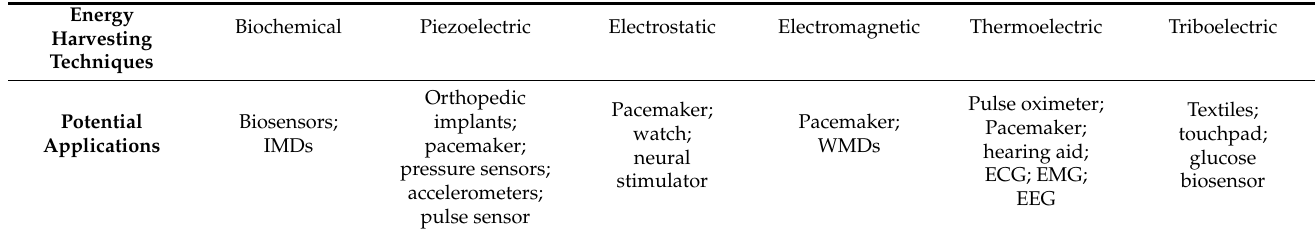
Table 4. Summary of potential applications of human-centric energy harvesters.